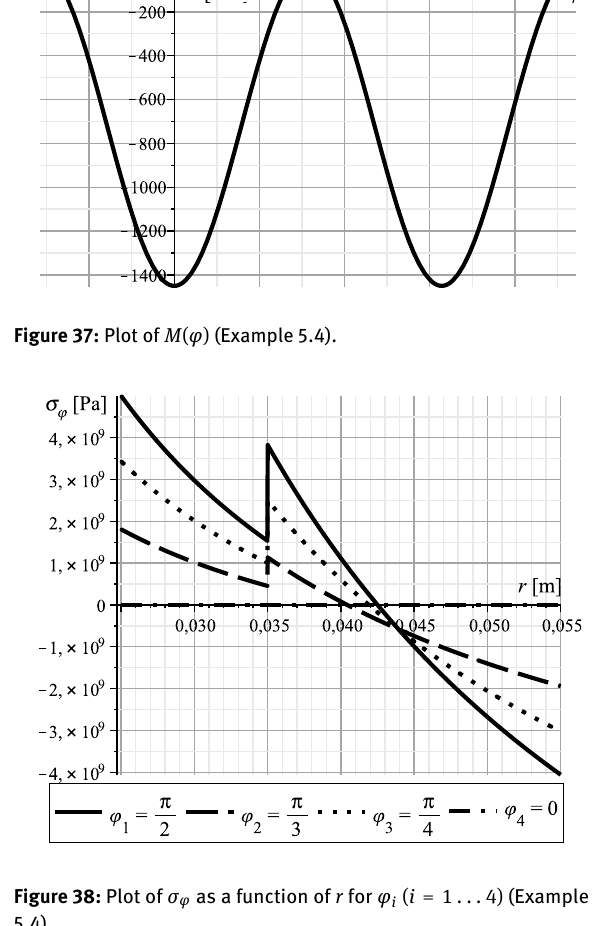
Figure 38: Plot of σ φ as a function of r for φ i ( i = 1 . . . 4) (Example 5.4).